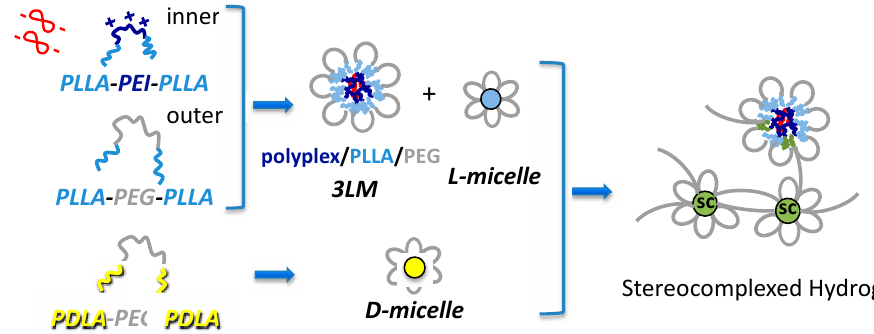
Figure 1. Schematic representation of 3LM and hydrogel components. Table 1. Composition ratios of inner:outer polymers in 3LM and mixed PEG block sizes in D-micelles.